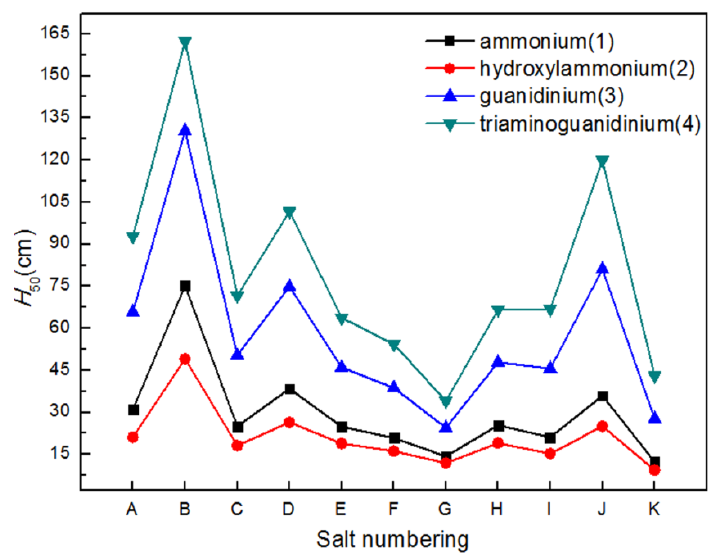
Figure 6. Comparison of the impact sensitivity ( H 50 ) of ammonium-based 4,8-dihydrodifurazano[3,4- b , e ]pyrazine-based salts.